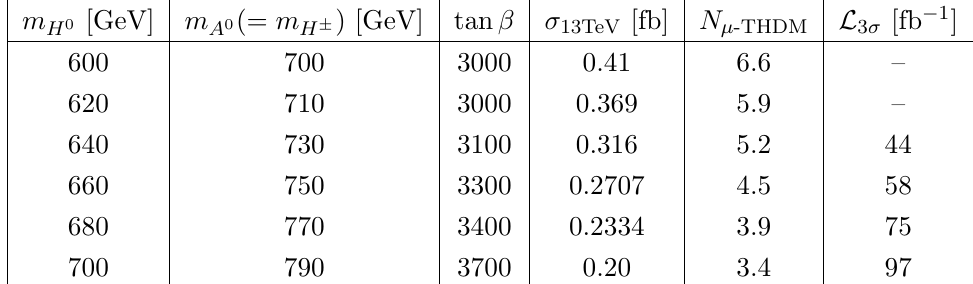
Table 2 . The parameter points that we investigate. (cid:27) is de(cid:12)ned in eq. (3.40). N (cid:22) -THDM is 13TeV the expected signal event numbers in the last bin of (cid:12)gure 2(b) in ref. [40]. L 3 (cid:27) is the integrated luminosity at which we can expect 3 (cid:27) deviation from the SM prediction if we apply the same analysis as ref. [40]. The data points with \-" in the last column are already